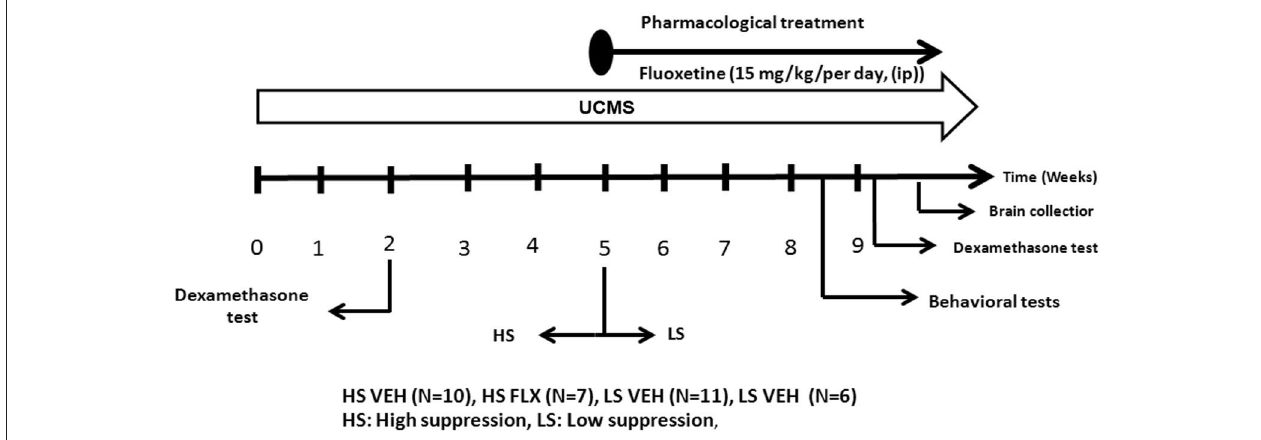
the mice were treated daily with vehicle while the other half was daily treated with fluoxetine (ip, 15 mg/kg/per day). At the end, behavioral tests were performed as well as a second dexamethasone suppression test. HS: High suppresser, LS: Low suppresser, VEH: vehicle, FLX: